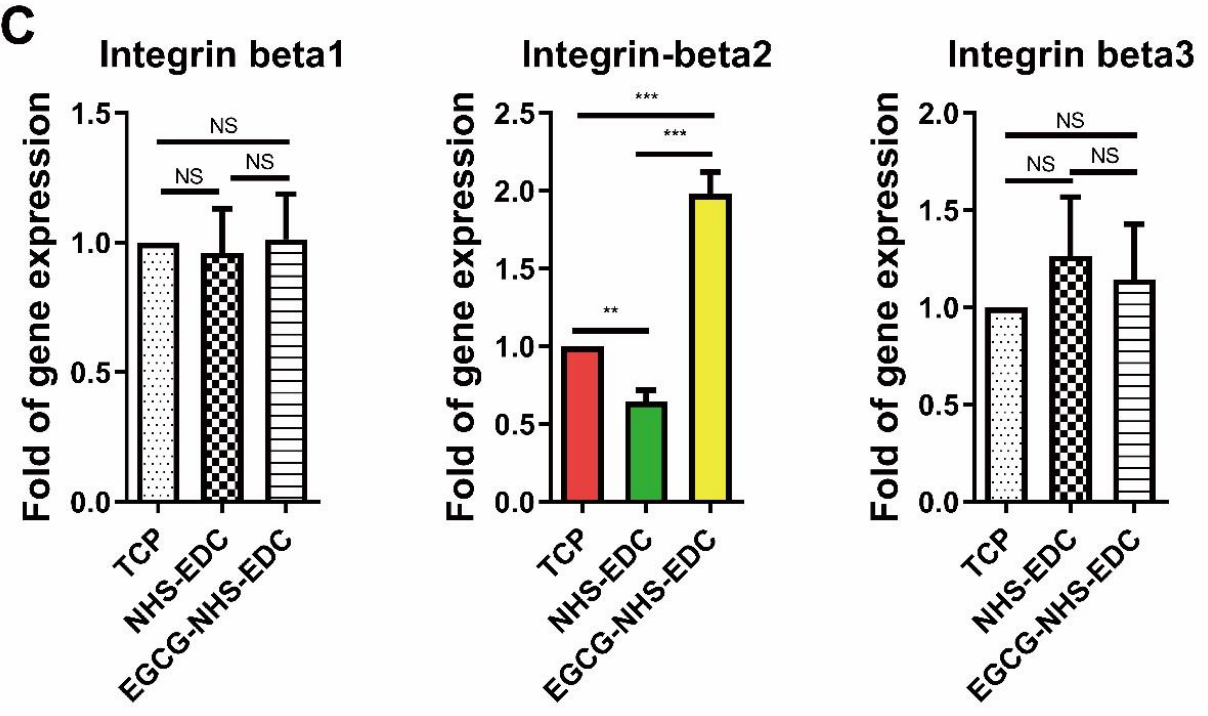
Figure 5. SEM images of Raw 264.7 cells cultured on EDC/NHS and EGCG treated EDC/NHS collagen membranes under low ( A ) and high ( B ) magnification, and the expression levels of integrin beta 1, 2, and 3, after culturing on TCP, EDC/NHS-Col and EGCG-EDC/NHS-Col for 10 min ( C ), respectively. NS = no significance, ** p < 0.01, *** p < 0.001, one-way ANOVA with Tukey’s multiple comparison testing.